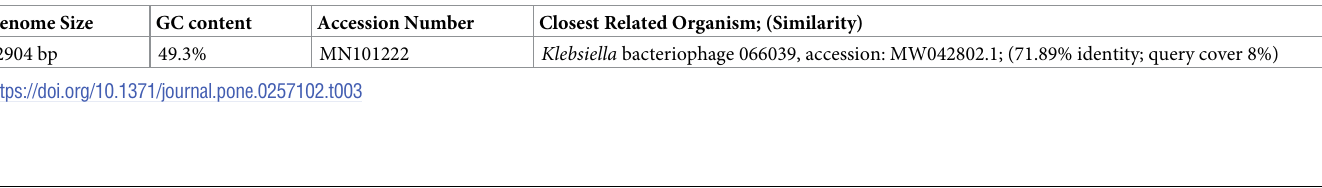
Table 3. KMI8 genome data and closest